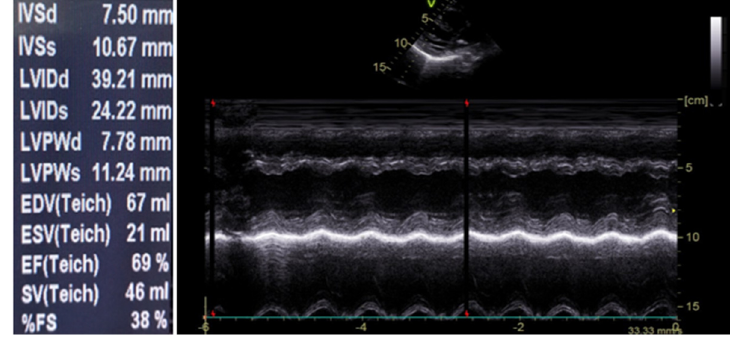
Figure 2. Cardiac echocardiography on Day 2.